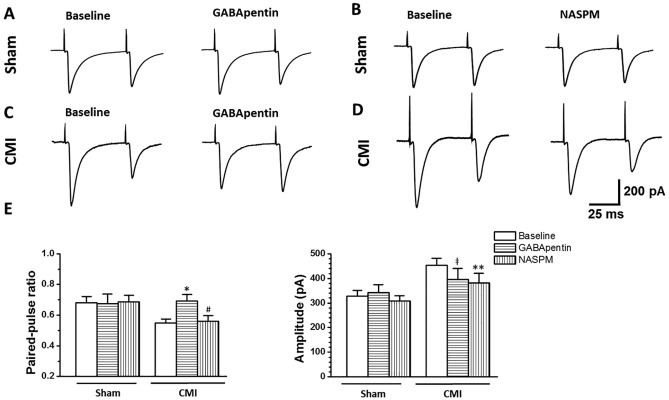
The paired-pulse responses were affected by GABApentin and NASPM in different ways.(A-B) Bath application of GABApentin (50 μm) or NASPM (50 μM) has no effect on the ratio and amplitude of the paired-pulse depression (PPD) in rats with sham surgery. (C) GABApentin increased the ratio of the PPD and inhibited the amplitude of the first eEPSC in rats with CMI. (D) NASPM decreased the amplitude of the paired responses but did not affect the paired-pulse ratio in CMI rats. (F) Summarized results for the effects of GABApentin and NASPM on the paired-pulse responses in rats with sham or CMI treatment. #, NASPM vs. baseline, p > 0.05; ǂ, GABApentin vs. baseline, p > 0.05; *, GABApentin vs. baseline, p < 0.05; **, NASPM vs. baseline, p < 0.01.